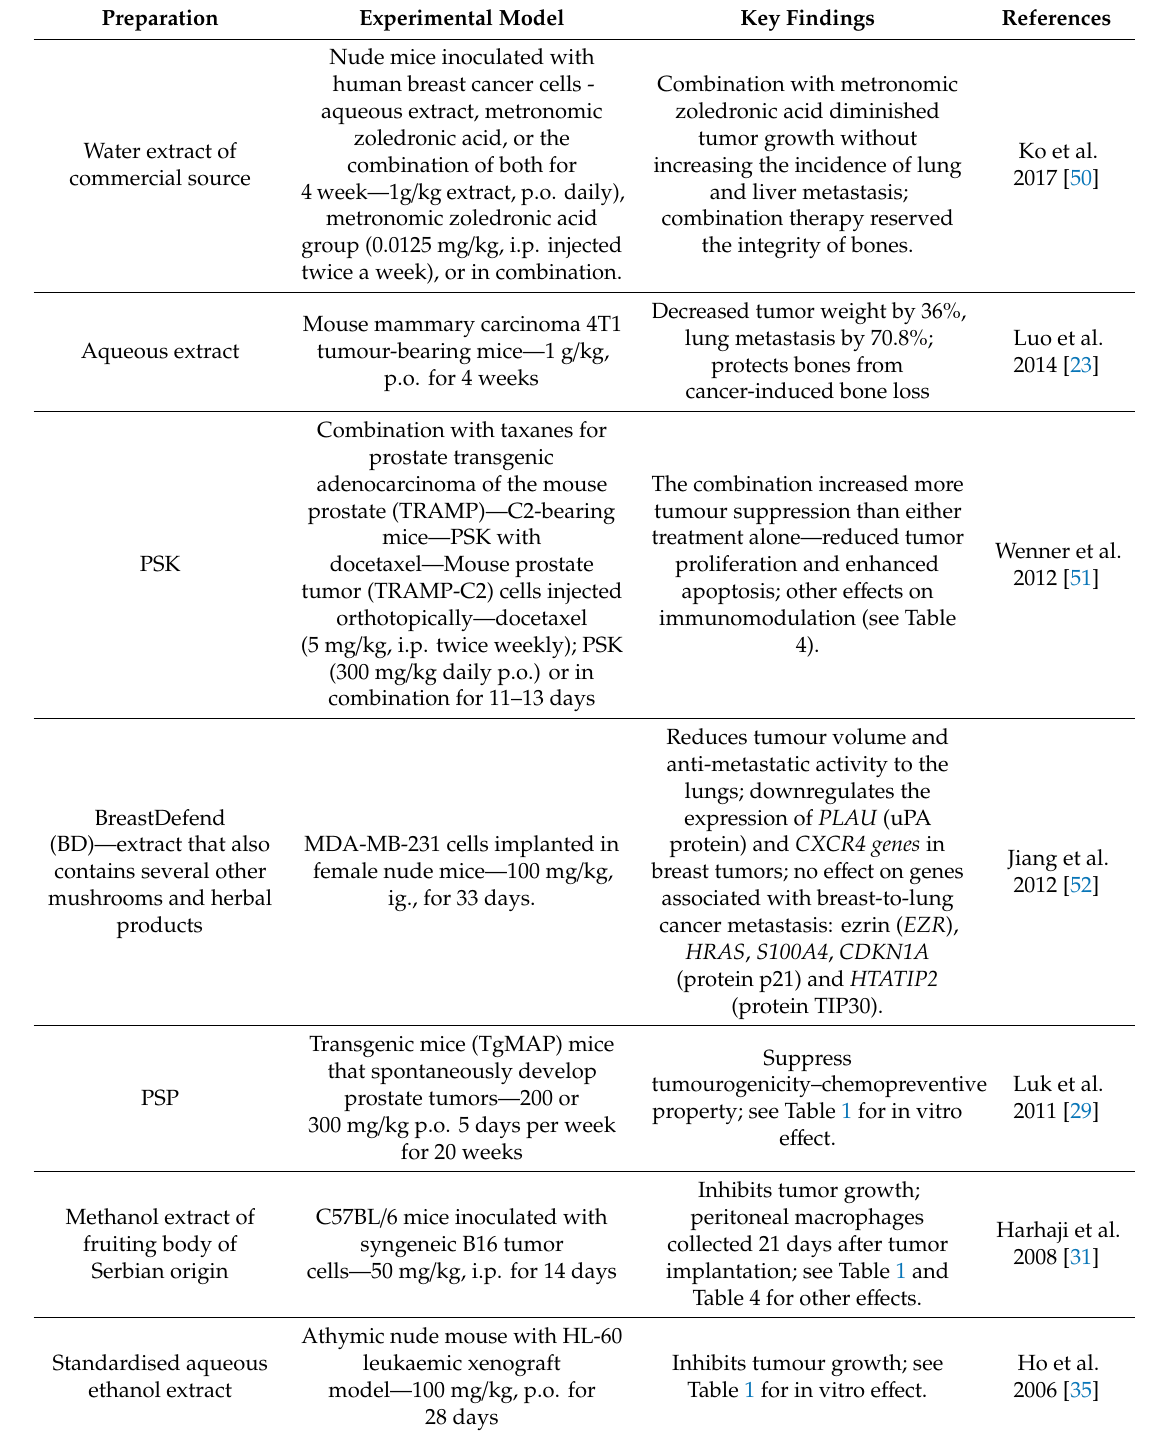
Table 1 for in vitro e ff